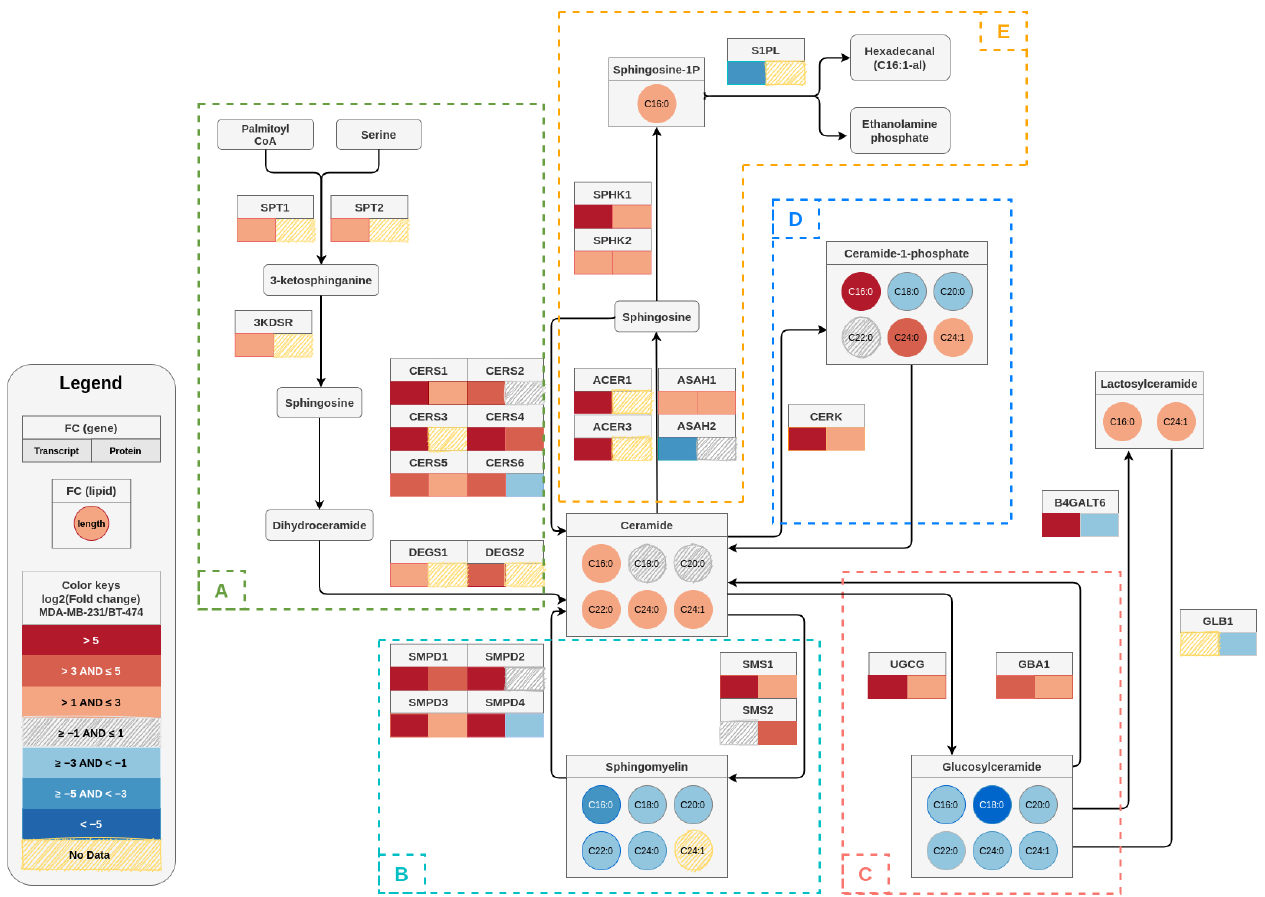
Figure 9. A sphingolipid pathway map depicting the log2 transformed fold changes in transcript, protein, and metabolite (sphingolipid) levels in MDA–MB–231 cells in comparison to BT–474 cells. For each gene, the corresponding transcript and protein fold changes are denoted as color-coded boxes below the gene name (transcript at the left and protein at the right of the box). In case of lipids, circles are used to describe the fold changes for a particular chain length. The color keys given in the legend box describe the color scale of different bins of log2 (fold change) that represents the degree of upregulation or downregulation in gene/protein/metabolites between cell lines The dashed boxes ( A – E ) indicate the de novo pathway ( A ) and various salvage pathways ( B – E ).